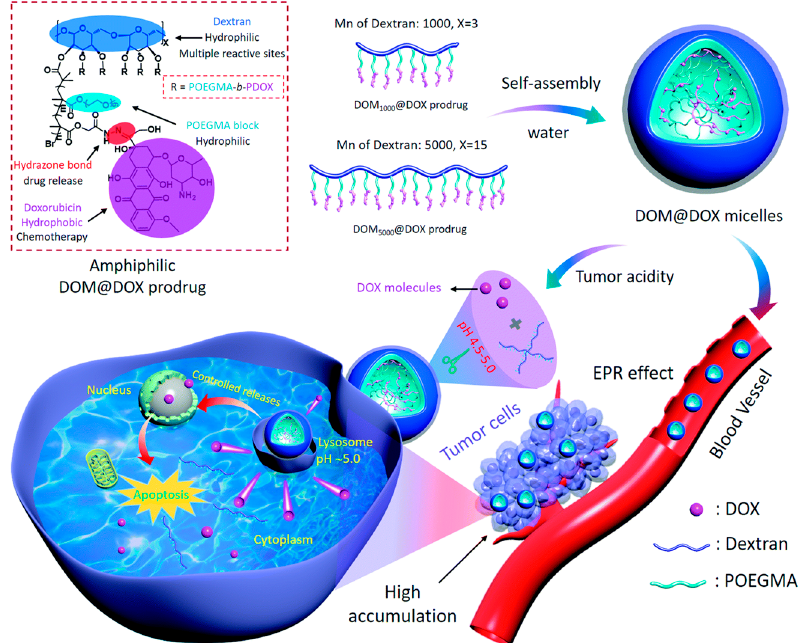
Figure 4. Schematic illustration of the synthetic route of acid-activated supramolecular nanoprodrug (DOM@DOX) micelles, drug accumulation via the enhanced permeability and retention (EPR) effect, cell internalization process, and pH-responsive drug release mechanism. Taken from [64].